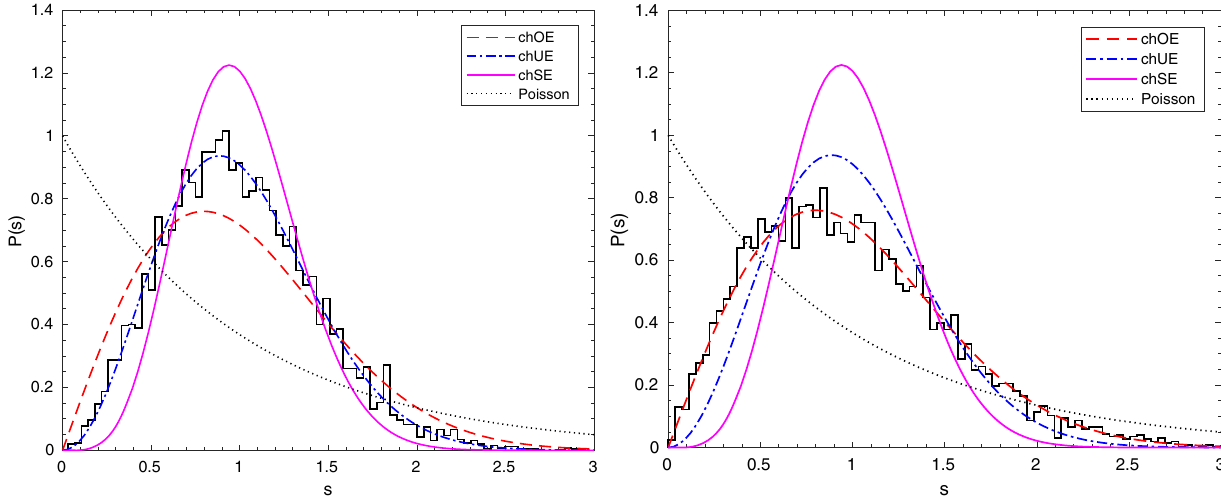
Fig. 5 Same as in Fig. 4, but for the unfolded density of eigenvalue spacings obtained from spectra of the staggered Dirac operator in the fundamental (left-hand-side panel) and sextet (right-hand-side panel) representations of the SU ( 4 ) gauge group. The results were obtained from quenched simulations on a lattice of hypervolume ( L / a ) 4 = 4.